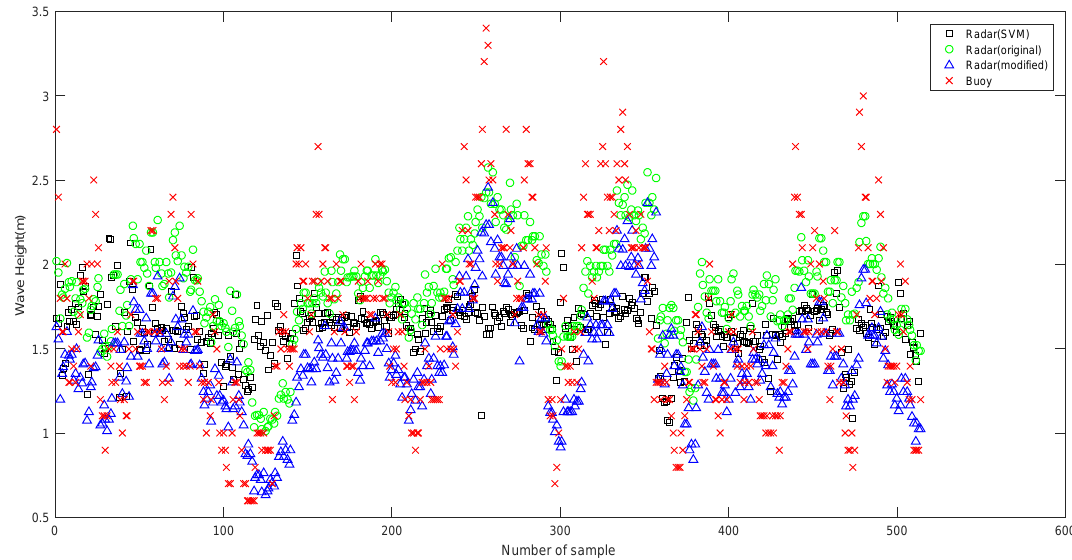
Figure 13. The time sequences of significant wave height. The horizontal and vertical axes represent time sequence and significant wave height, respectively. The black square denotes the radar-retrieved significant wave height based on the SVR method and shadowing information. The green circle denotes the radar-retrieved significant wave height based on the traditional method. The blue triangle denotes the radar-retrieved significant wave height based on the modified method. The red cross denotes the significant wave height of buoy